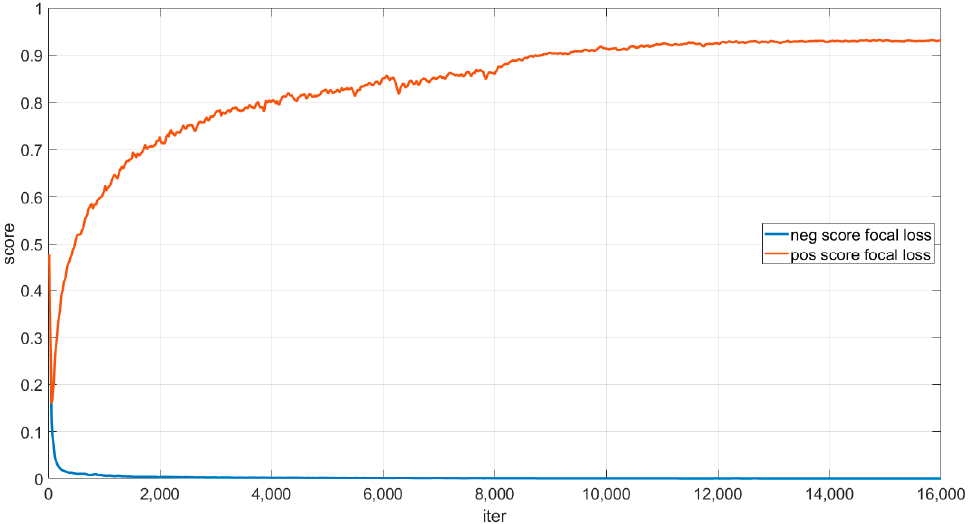
Figure 4. Curves of the average classification scores of positive and negative samples output from the network trained by focal loss during the training phase.